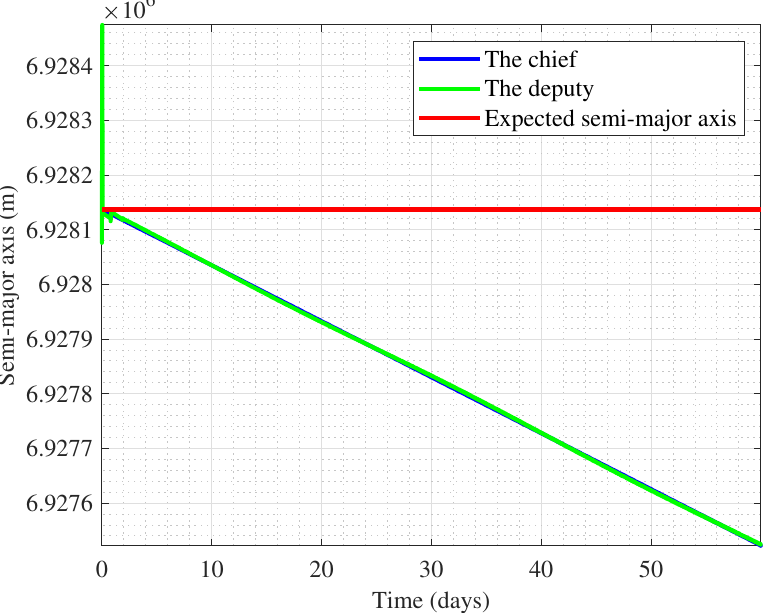
Figure 8. Semi-major axis time histories without semi-major axis control.